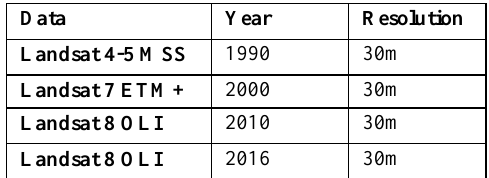
Table 1 Data acquisition of remotely sensed imagery